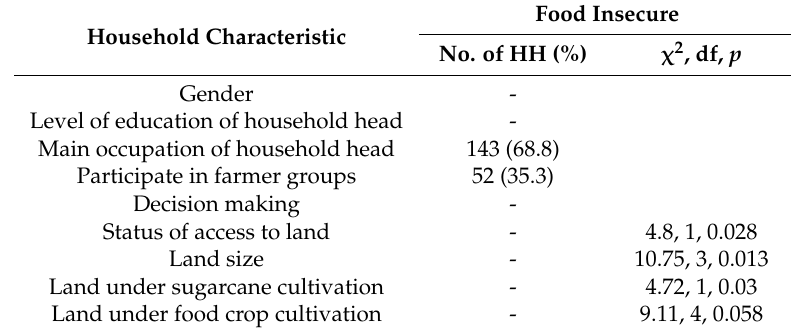
No. of HH (%) = Number of households